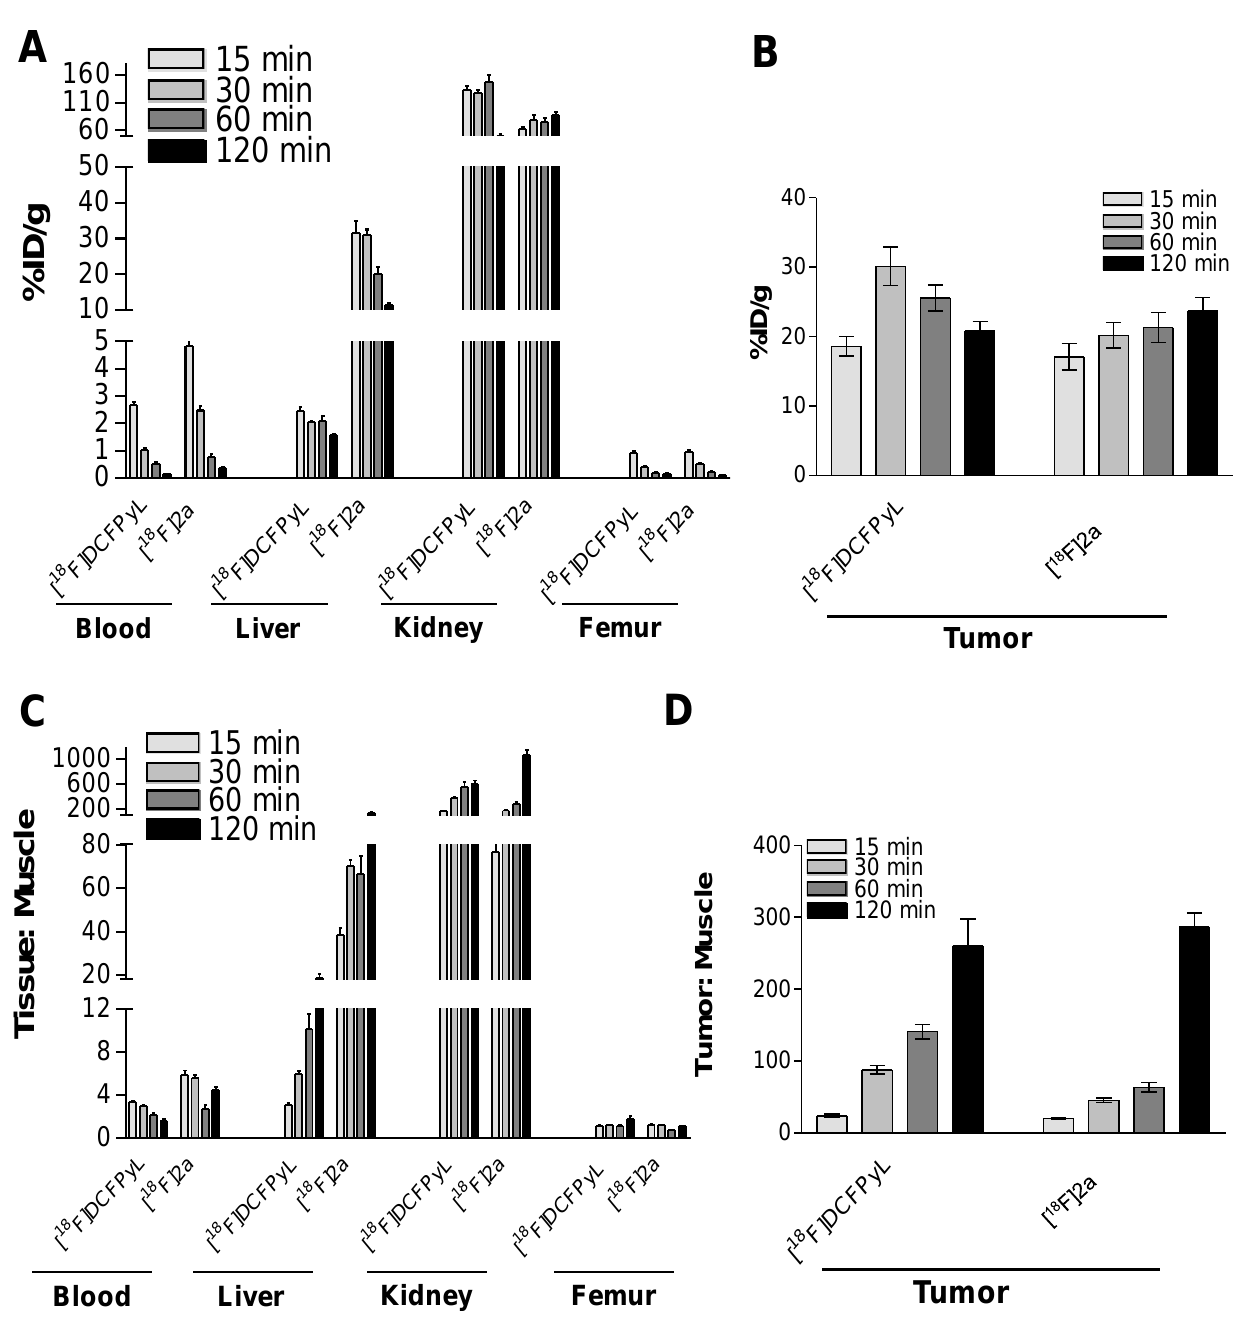
Figure 6. ( A , B ) Pharmacokinetic comparisons of PC3(+) xenograft biodistributions in blood, non- target and target (tumor) tissues [%ID/g (normalized to 20 g mouse)] of [ 18 F]DCFPyL and [ 18 F] 2a from 15 to 120 min. ( C , D ) Pharmacokinetic comparisons of Tissue (%ID/g) to Muscle (%ID/g) ratios (T:M) of [ 18 F]DCFPyL to the analogue [ 18 F] 2a determined from PC3(+) xenograft biodistributions from 15 to 120 min. Each bar represents the mean (%ID/g or T:M) ± SE [ n = 8 – 10 ([ 18 F]DCFPyL); n = 5 – 6 per group ([ 18 F] 2a )].